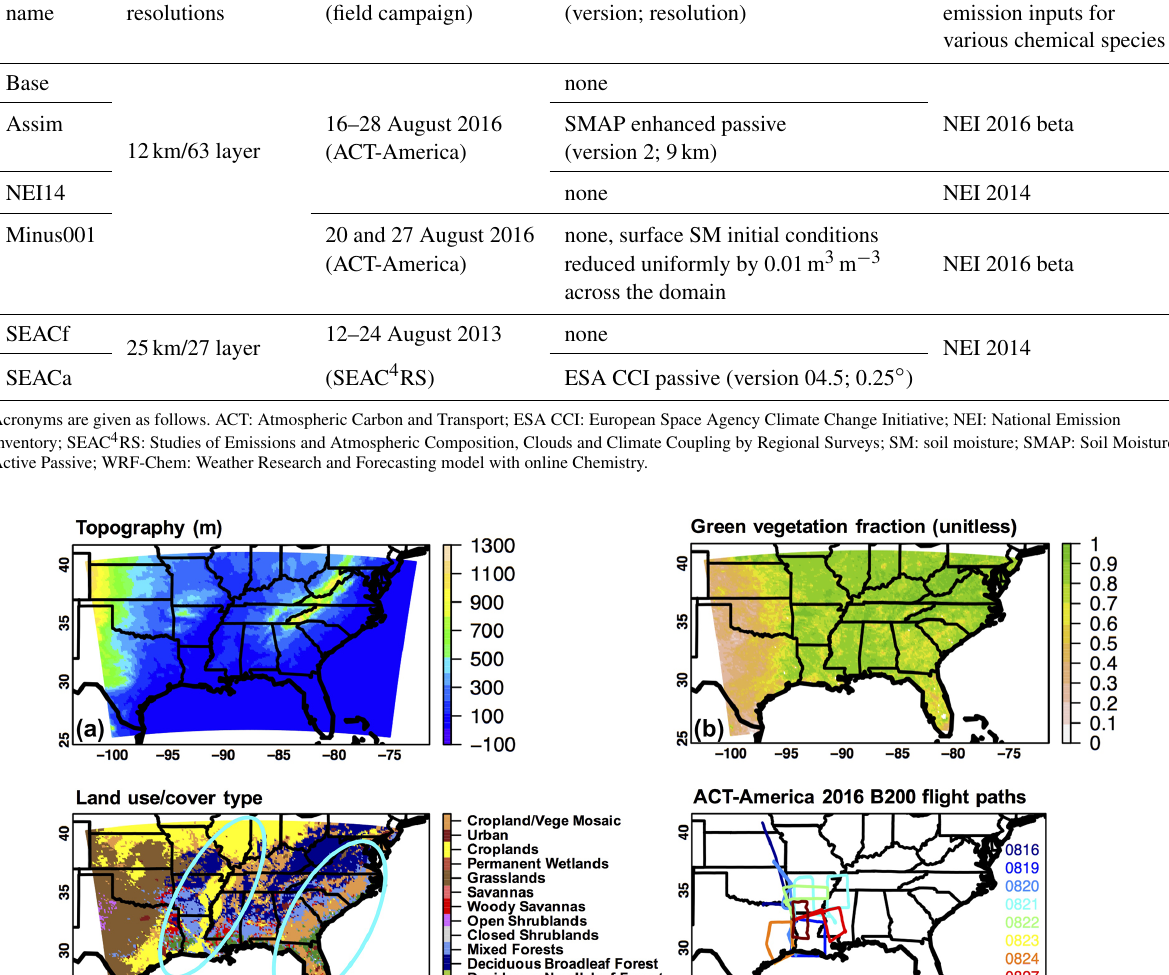
Table 1. Summary of WRF-Chem simulations conducted in this study. Case